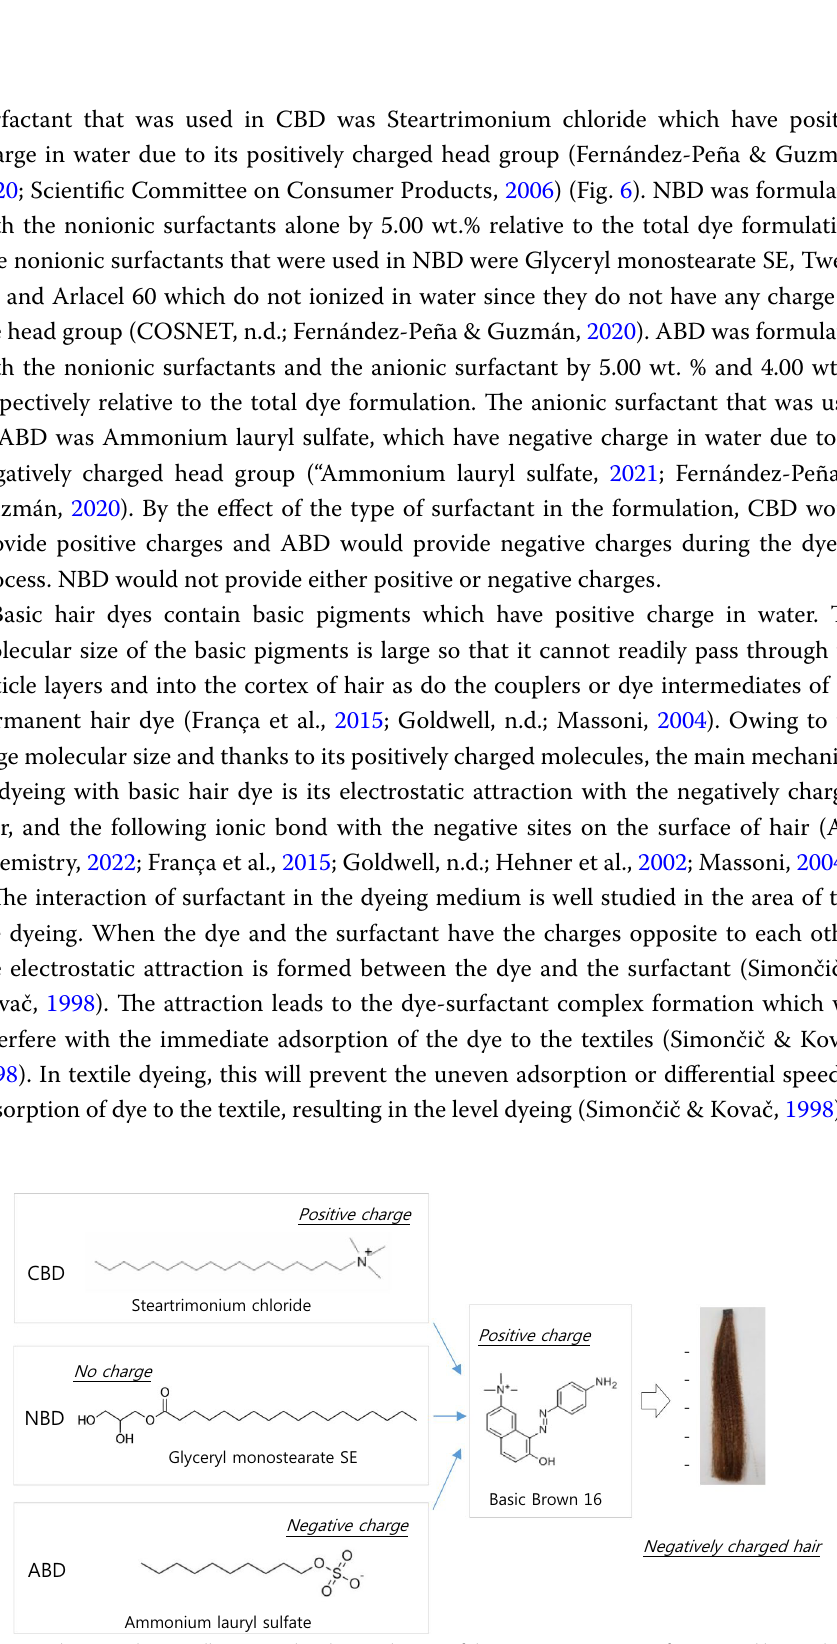
Fig. 6 Schematic diagram illustrating the electric charges of dye (Basic Brown 16), surfactant, and hair in the dyeing medium of Cationic (CBD), Nonionic (NBD), and Anionic (ABD) basic hair